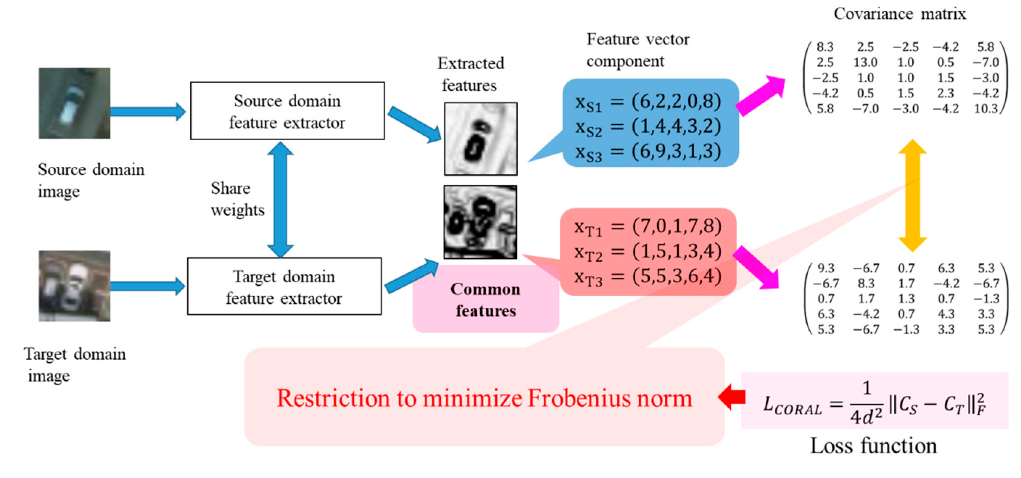
Figure 2. Overview of Correlation alignment (CORAL) domain adaptation (DA).